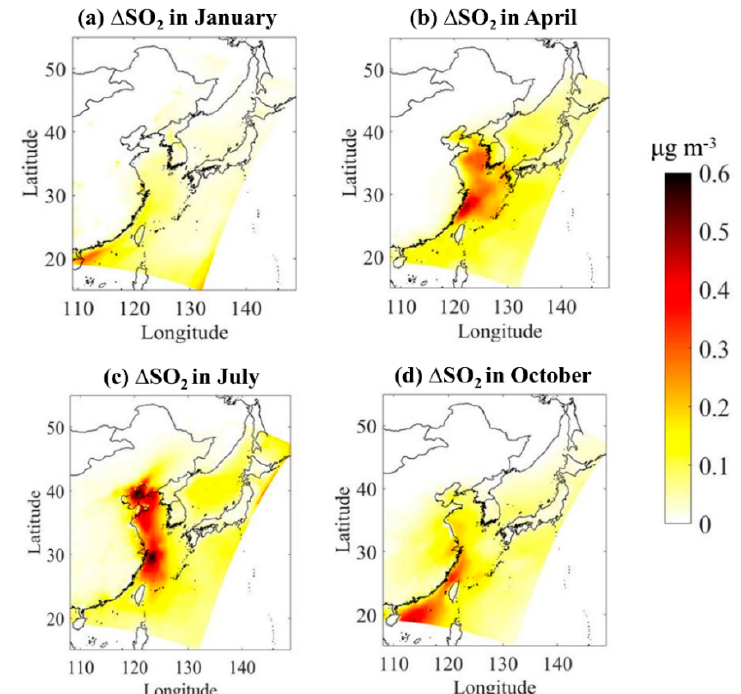
Figure 4. Absolute impacts of marine DMS emissions on monthly mean atmospheric SO 2 over Chinese seawater in four typical months of ( a ) January, ( b ) April, ( c ) July, and ( d ) October.